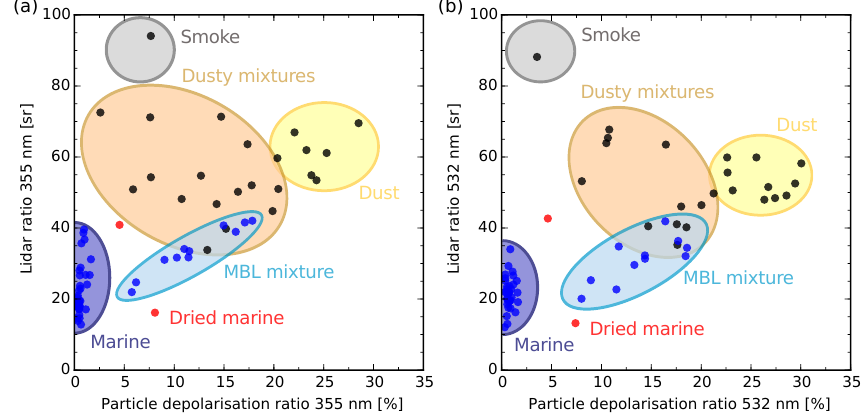
Figure 14. Lidar ratio as a function of the particle depolarisation ratio at 355nm (a) and at 532nm (b) from all analysed MBL (blue), elevated aerosol layer (black), and dried marine layer (red) measurements of PS95 and PS98. Coloured ellipses denote the different aerosol